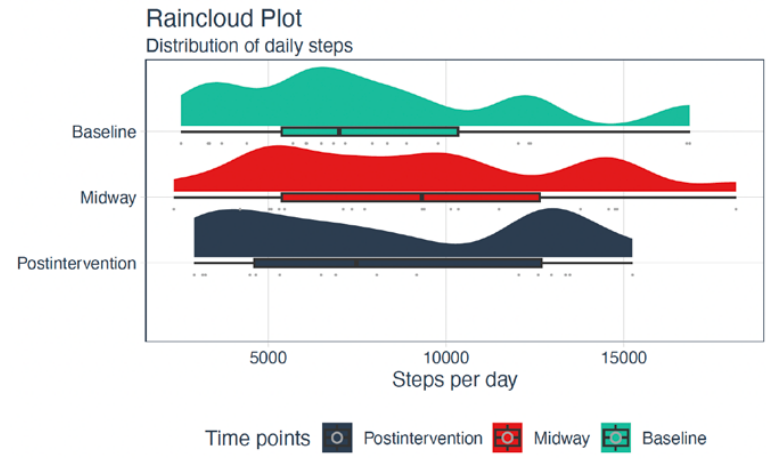
Figure 3. Raincloud plot representing an illustration of data in a half-density distribution (the ‘cloud’) with individual raw data (the ‘rain’) and a boxplot below the ‘cloud’ of the total daily mod- erate to vigorous physical activity (MVPA) in minutes at baseline, midway, and post-intervention.